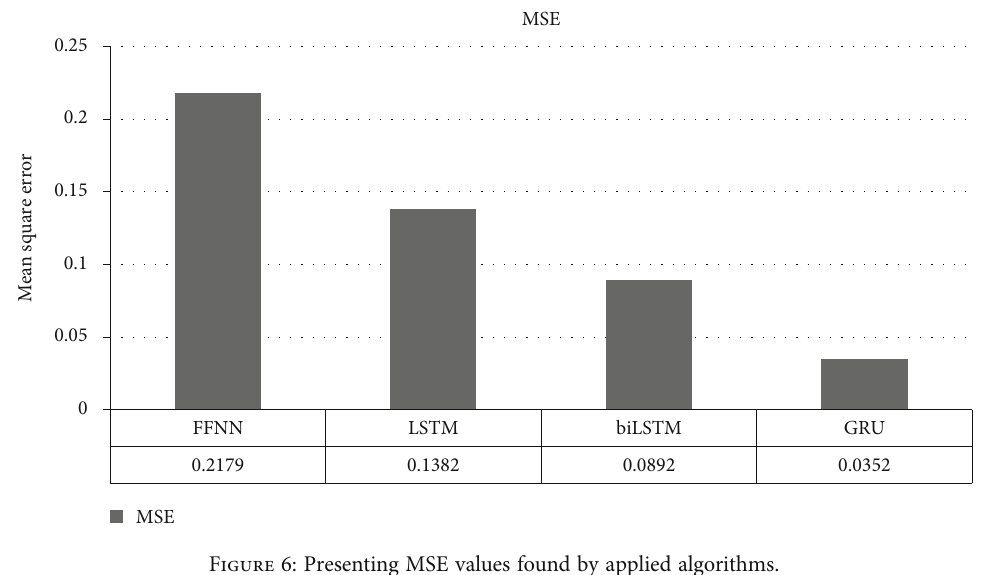
Figure 6: Presenting MSE values found by applied